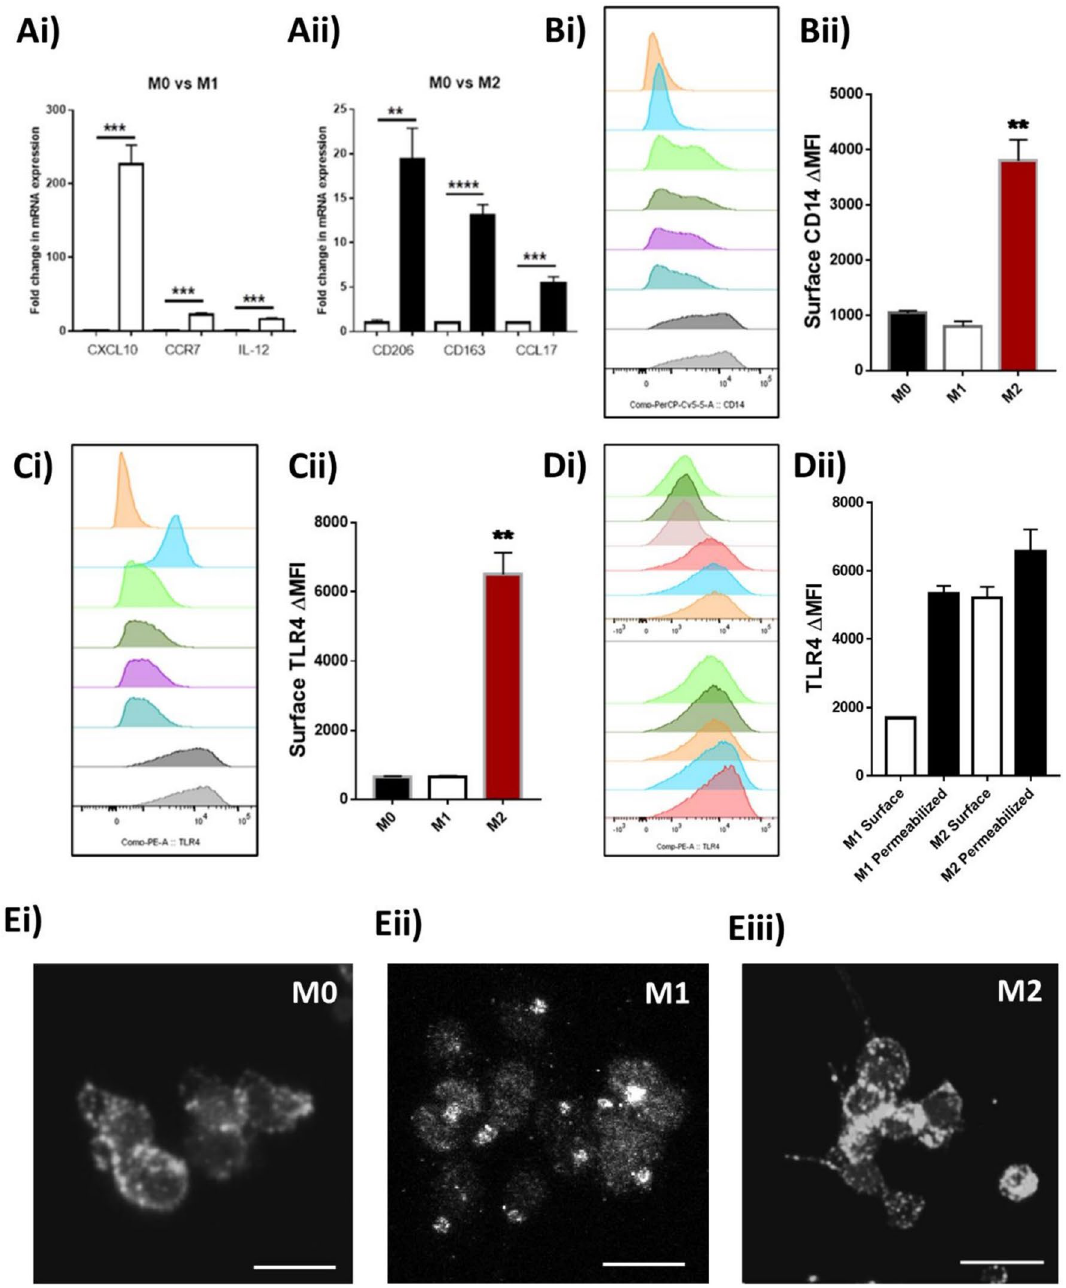
Figure 1. Differentiated M1 and M2 macrophage expression of TLR4 in vitro. PMA differentiated THP-1 monocytes (Resting M0-Macrophages) were stimulated for 24 h with either (50 ng/ml) recombinant human IFNγ (M1 polarization) or 25 ng/ml each of recombinant human IL-4 and IL-13 (M2). Polarity of matching sets of macrophages were initially confirmed by ( A ) qPCR analysis for ( Ai ) M1 markers: CXCL10, CCR7, IL-12 or ( Aii ) M2 markers: CD206, CD163, CCL17. Cell surface expression of ( B ) CD14 or ( C ) TLR4 was determined through flow cytometric analysis. Further analysis of total expression of TLR4 through permeabilization of cells and comparison to cell surface staining reveals ( D ) Abundance of TLR4 on the surface or total (including internal) of M1 and M2 polarized THP-1 macrophages. ( E ) Single colour immunofluorescent confocal microscopy images of TLR4 expression within ( Ei ) M0, ( Eii ) M1, ( Eiii ) M2 macrophages show differential patterns of staining within the cells. Images are a representative of 3 independent experiments. qPCR data is expressed as the mean ± SEM of 3 independent differentiations of THP-1 derived macrophages of passages 5–8. (Histograms: Pink-isotype control, Blue—THP-1 monocyte controls, Green and Dark Green—M0 macrophages, Purple and Blue—M1 macrophages, Dark and light grey—M2 macrophages). Scale bar = 20 µm. Statistical analysis performed on qPCR data was a two tailed multiple unpaired students t-test comparing stimulated to control, **P < 0.01, ***P < 0.001, ****P <